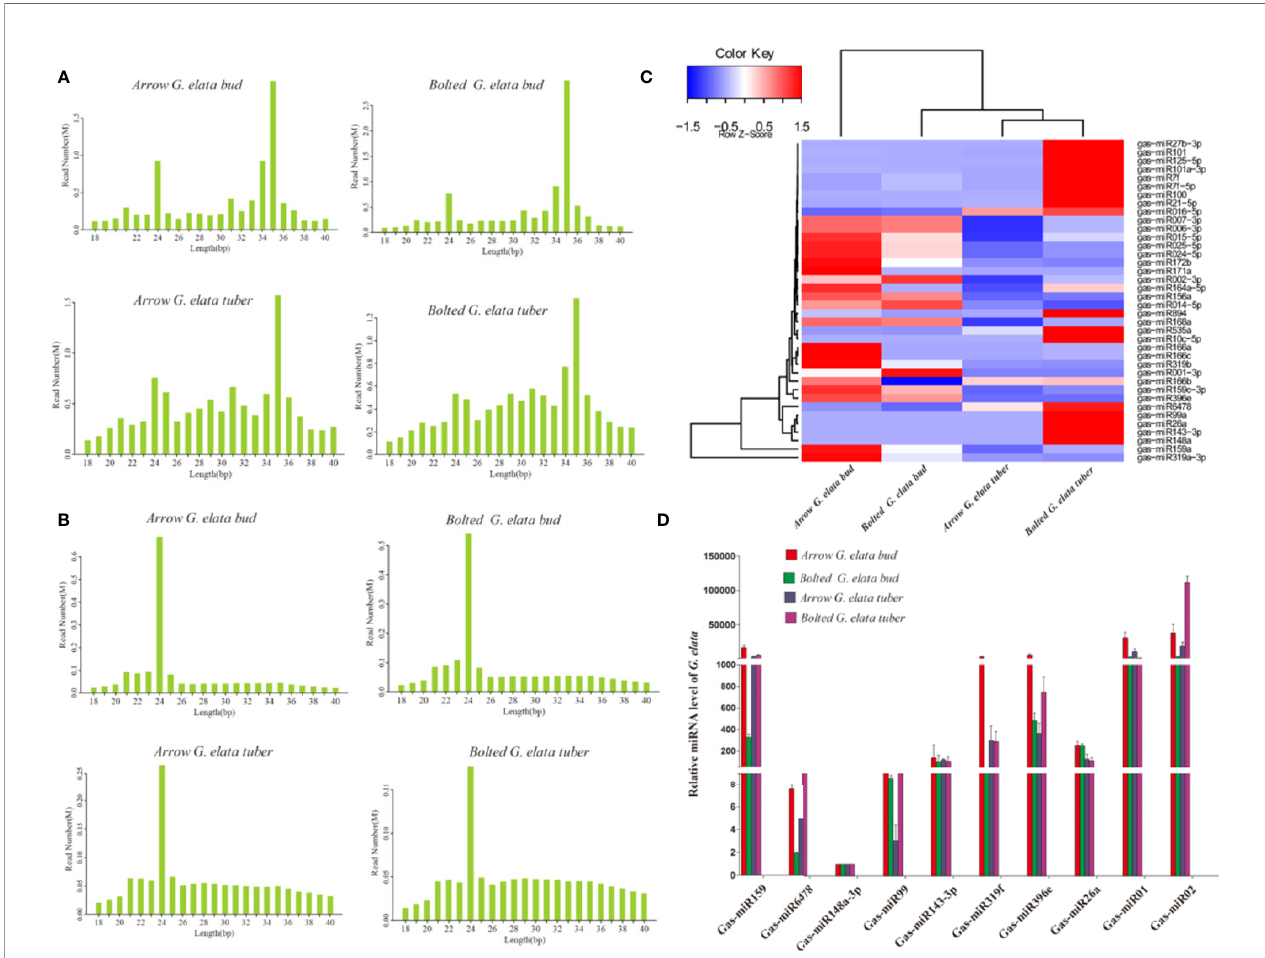
FIGURE 2 | Length distribution of G. elata sRNA and expression pro fi les of 10 G. elata miRNAs in different tissues. Length distributions of clean total reads (A) and clean unique reads (B) . (C) Clustering map of difference miRNAs. (D) Relative expression levels of 10 G. elata miRNAs in different